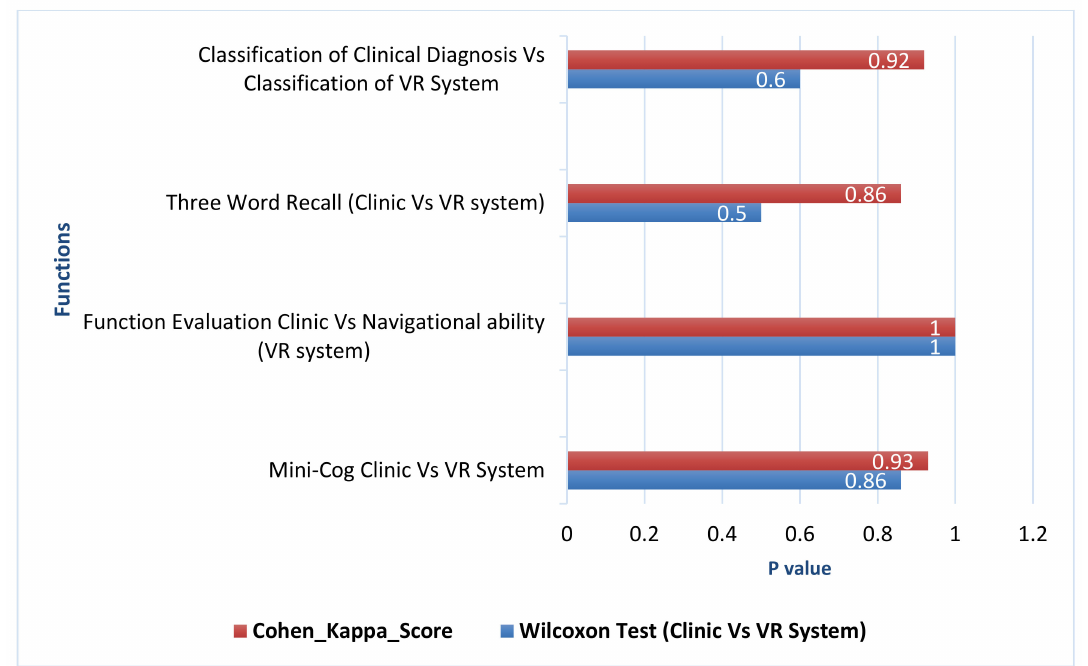
Figure 8. Wilcoxon test ( p -Value) and Cohen kappa of cognitive test in both clinic vs. vr